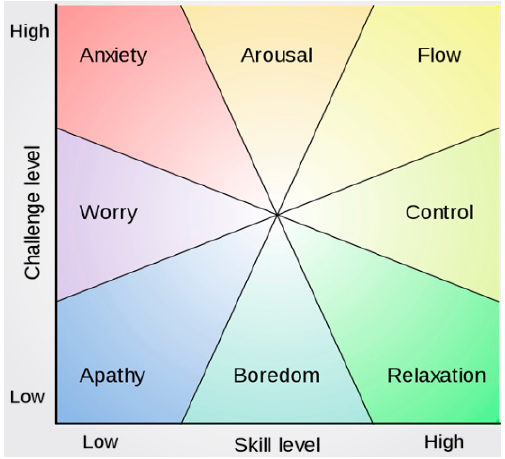
Figure 1. Emotional states in the Flow theory [47].